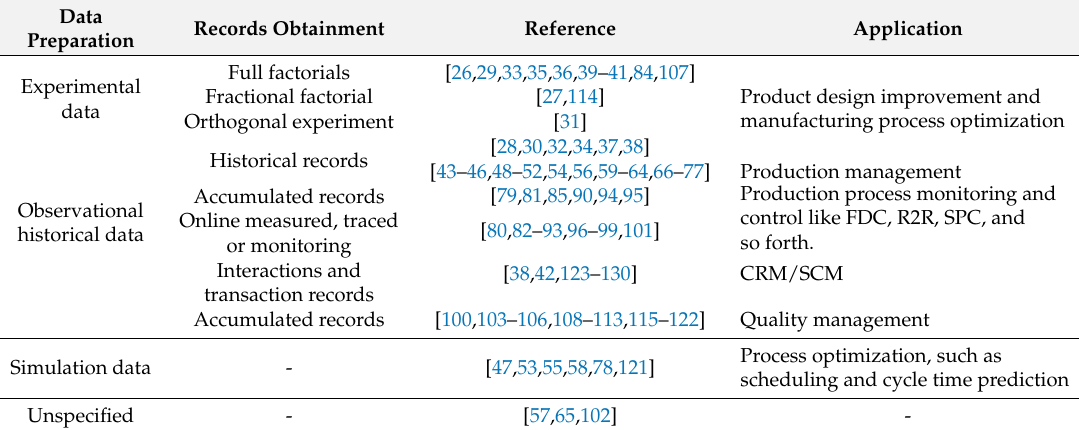
Table 6. The data preparation from the reviewed articles.